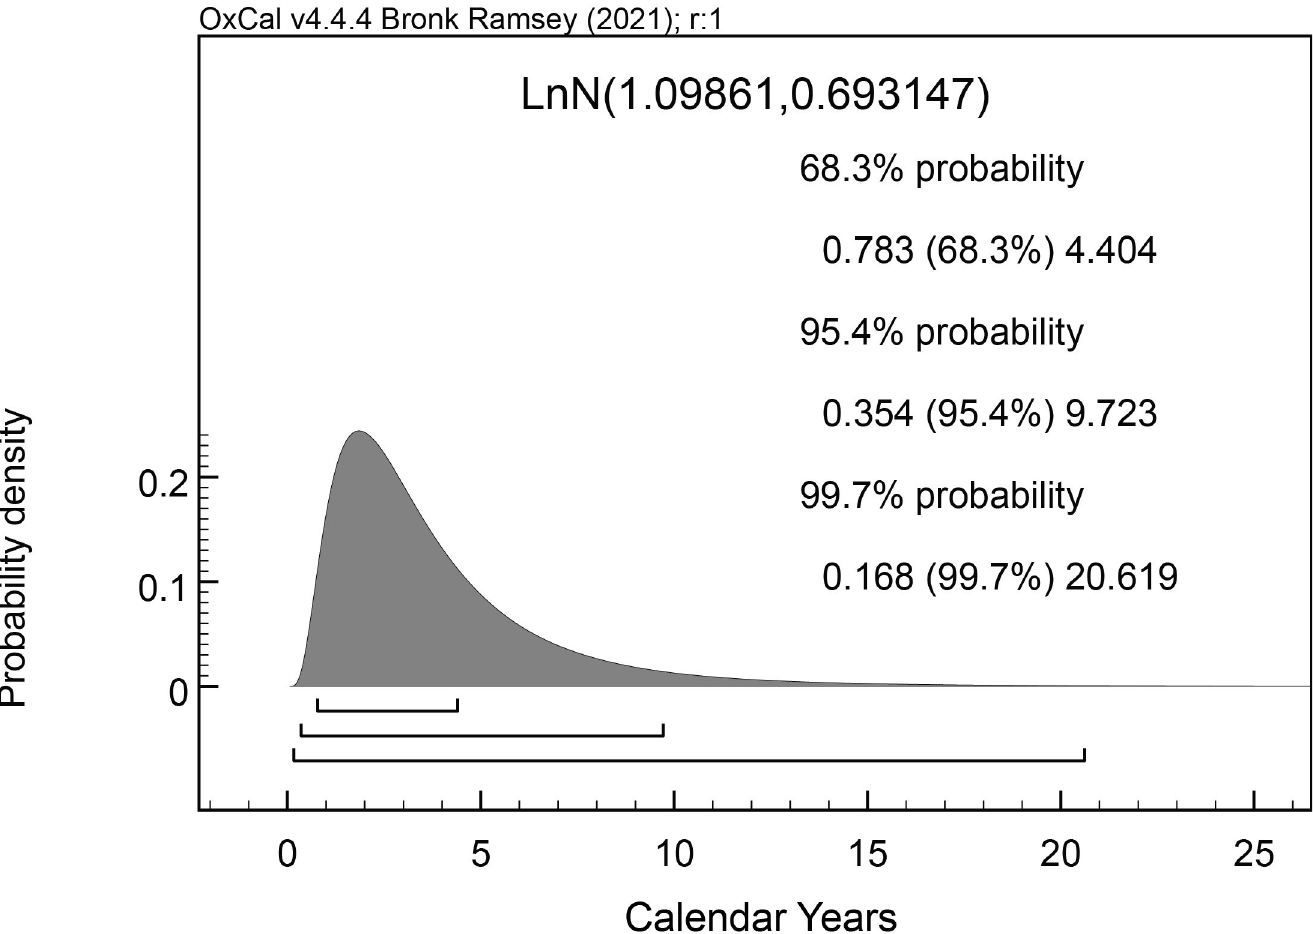
Fig 6. The prior probability distribution from the LnN(ln(3),ln(2)) constraint applied to the difference query in the OxCal [57] models discussed below (see Results).